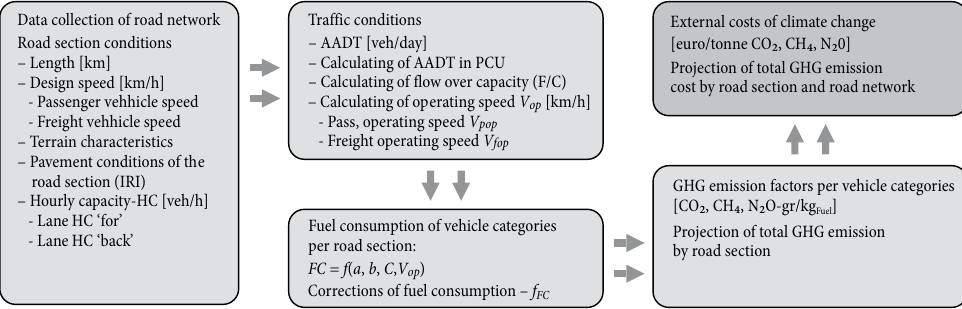
Fig. 1. Step approach to GHG emissions cost evaluation on the road